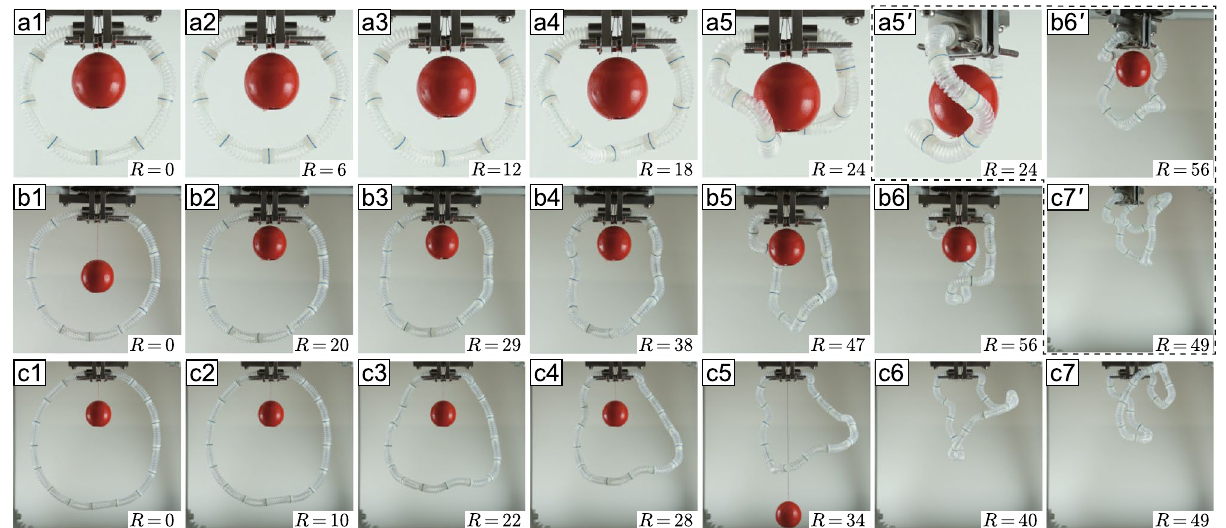
Figure 3. Deformation snapshots for n = 8, 12 , and 16: front views for ( a1 )–( a5 ) n = 8 at R = 0 –24, ( b1 )–( b6 ) n = 12 at R = 0 –56, and ( c1 )–( c7 ) n = 16 at R = 0 –49. Figure ( a5 ′ ), ( b6 ′ ), and ( c7 ′ ) inside the dashed box are the 60 ◦ -rotation images of ( a5 ), ( b6 ), and ( c7 ). Note that R is the number of rotation actions for the ratchet-type hand winch. In image processing, the overhanging red ball was used to extract the vertical axis of the center, with the string aligning with the rotation axis of the actuator. The indicator was lowered so as not to make contact with the deformed